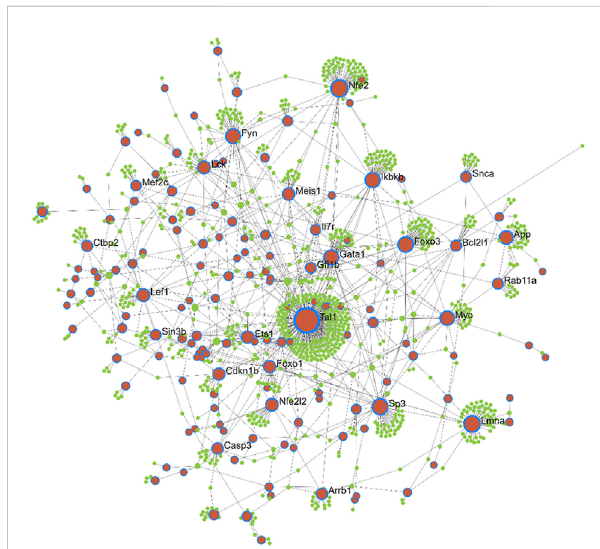
FIGURE 4 Protein-protein interaction network of the key module genes differentially expressed between AML and healthy mouse. Brown nodeswithblueborders:modulegenes(alsoknownasseedproteins).